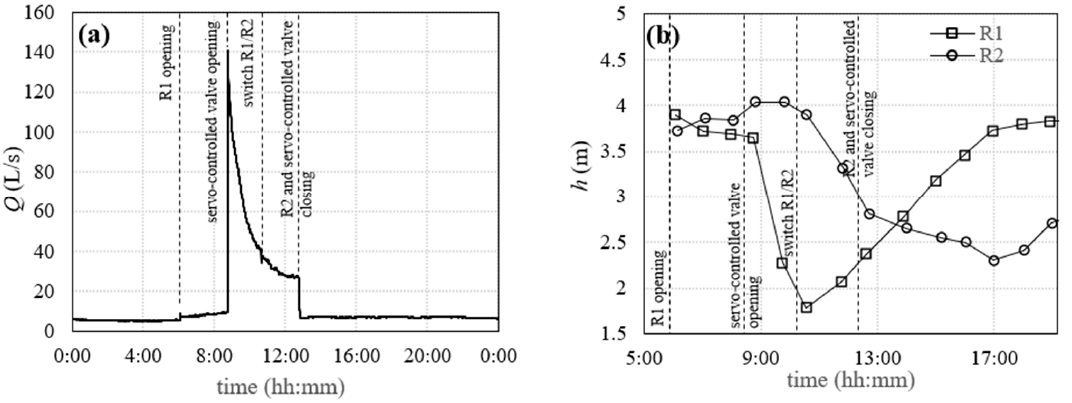
Figure 5. ( a ) Outflow discharge Q from the reservoirs, and ( b ) water levels in R1 and R2. Experiment of Wednesday, 3 July of Wednesday, 3 July 2019.